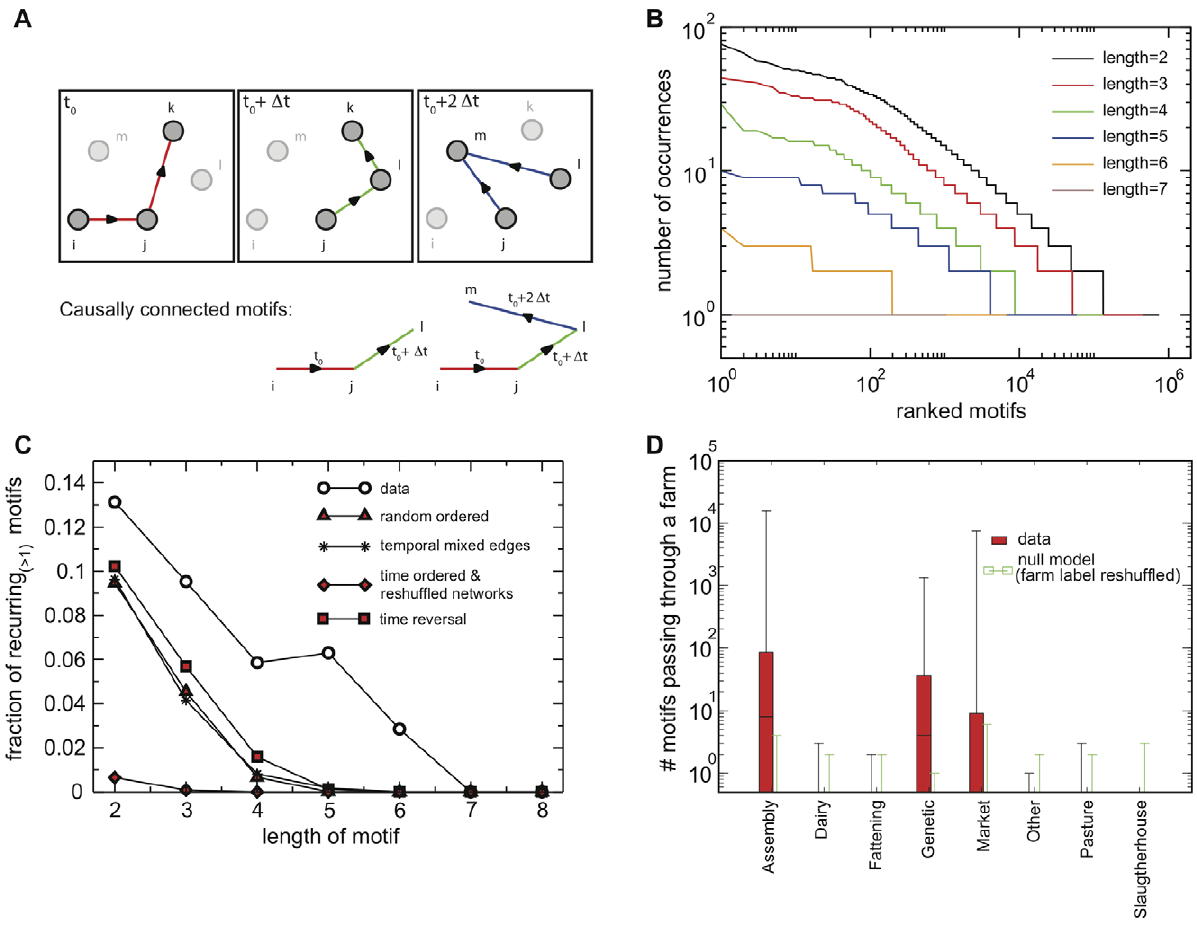
Figure 12. Motifs: schematic representation and their occurrence. A schematic example of the dynamics of a subset of the mobility networks is shown in panel A through three successive snapshots. The connections are color-coded according to the time at which they are active. A temporal motif is a temporal sequence of links such that the destination node of a link at time t 0 is the origin of another link at time t 0 z D t . Two examples of motifs, of respective lengths 2 and 3, are shown below. We restrict the present study to the case of D t ~ 1 day. Panel B shows the results on the presence of motifs, analyzed by counting the number of occurrences during the timeframe under study. The longer the motifs, the smaller the number of times they appear. By focusing only on the set of motifs that occur at least twice, panel C compares the size of this set (expressed as a fraction of the total) obtained from the empirical dataset with the sizes obtained through various randomization procedures (see main text). The results are shown as functions of the motifs length. In panel D the median and confidence intervals of the number of motifs passing through a farm depending on the farms type are shown, together with the same computation for a null model in which the farm types are reshuffled at random.